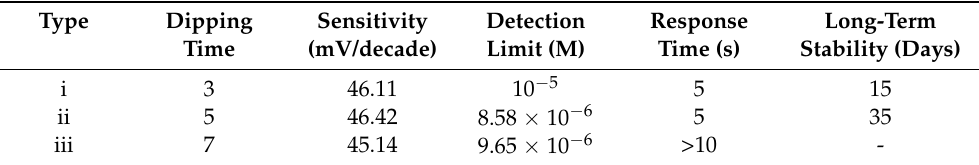
Table 2. Influence of dipping time on the characteristics of HA